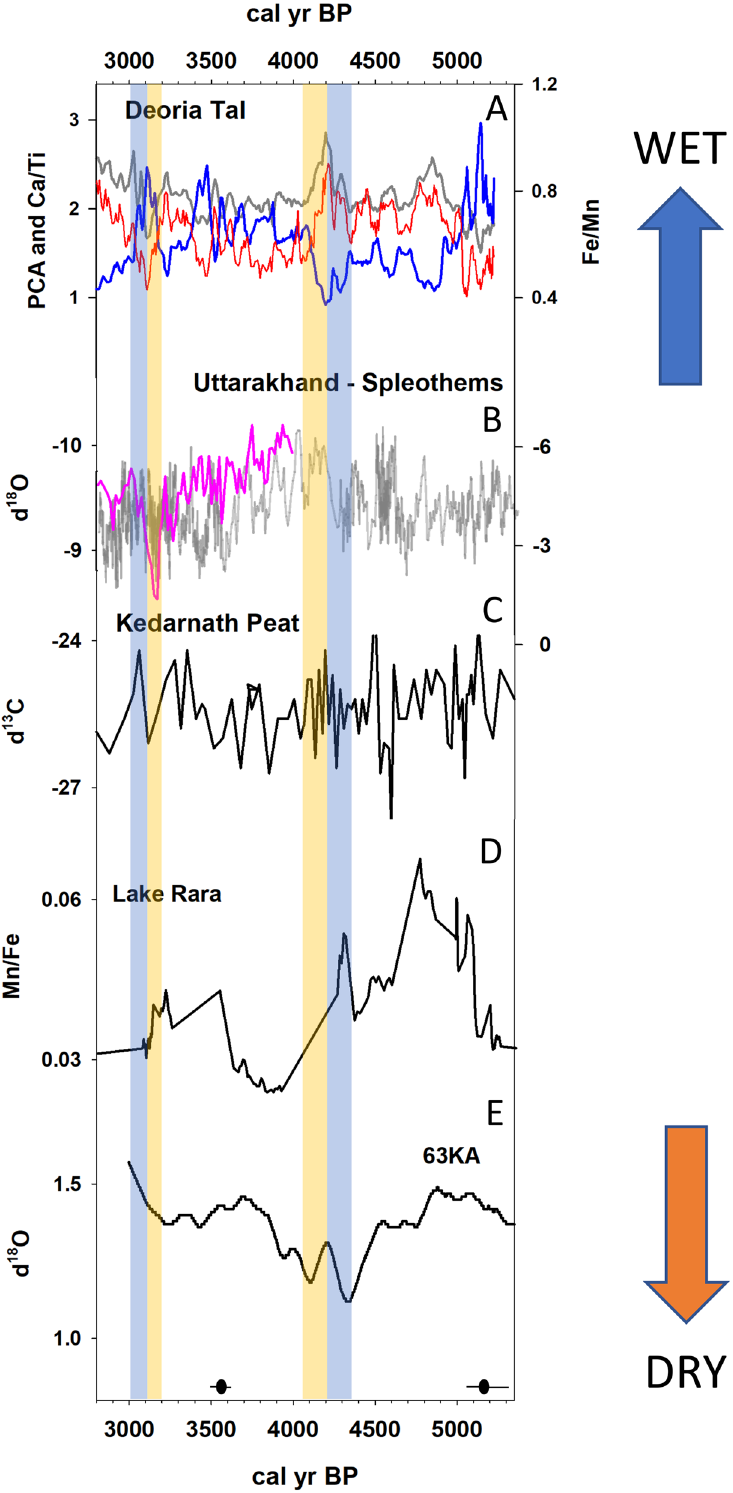
Figure 4. Synthesis figure depicting paleoclimate records from the region. ( A ) PCA Axis 1 scores (grey), Ca/ Ti (blue) and Fe/Mn (red), this study; ( B ) δ 18 O of speleothems (reversed scale) from Sainji Cave, Uttarakhand 13 (pink, right-hand scale); Sahiya Cave 4 (cyan, left-hand scale); ( C ) δ 13 C from Kedarnath peat bog, Uttarakhand 12 ; ( D ) Mn/Fe from Lake Rara, Nepal 14 ; ( E ) δ 18 O ( Neogloboquadrina dutertrei 315-400um − Globigerinoides ruber 400-500um ) from marine core 63KA, Arabian Sea 11 . The vertical tan and blue-shaded boxes represent intervals characterized by negative and positive hydroclimate anomalies, respectively. The mean value (black circle) and 2-sigma range (black line) for the calibrated ages, based on the radiocarbon dates, available for this portion of the core are also